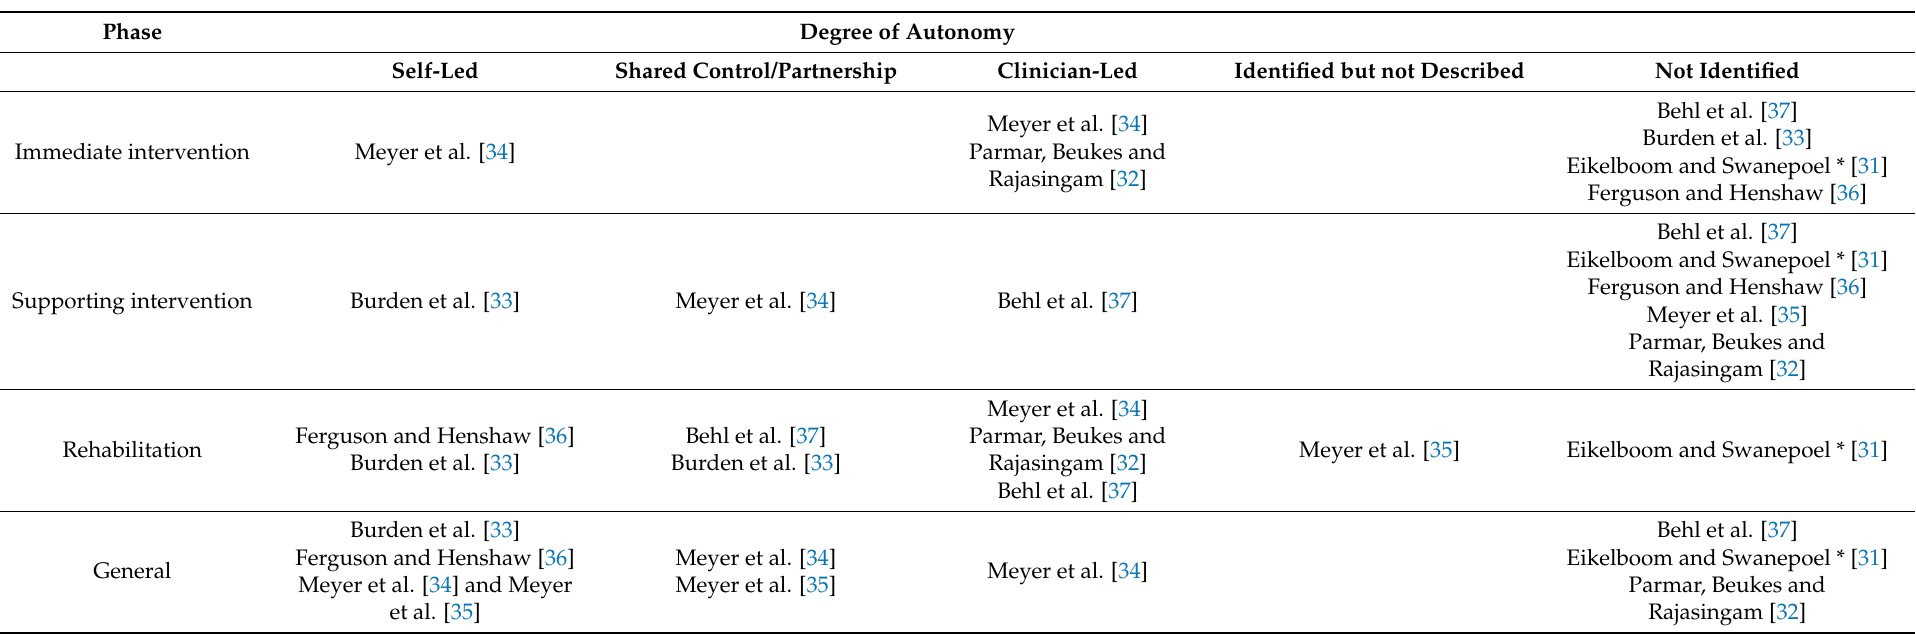
Table 4. Studies selected following screening and eligibility analysis with qualitative analysis according to audiological intervention process, tasks, and degree of autonomy